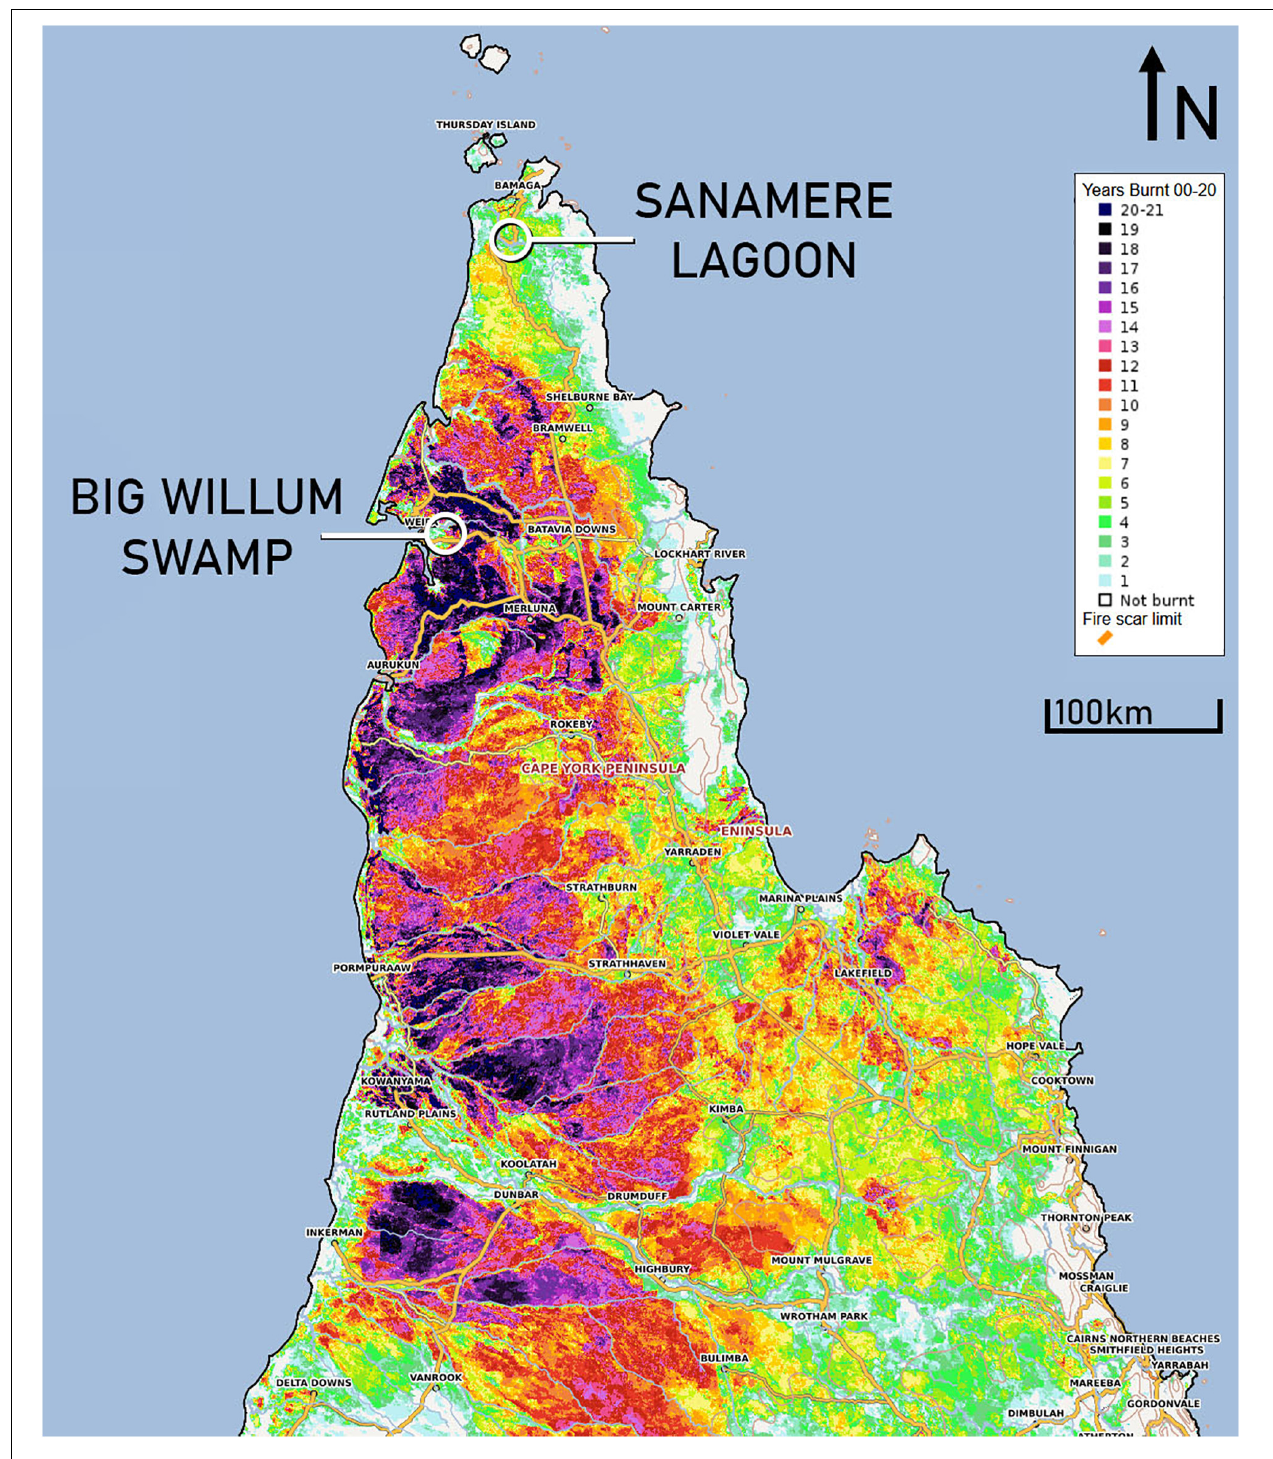
FIGURE 2 | Years burnt 2000–2020 for Cape York Peninsula (after Northern Australian Fire Information, 2021).